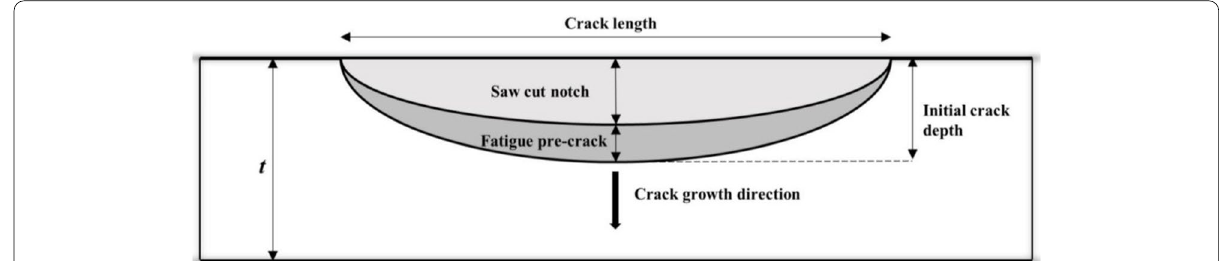
Fig. 3 Schematic diagram of notch and pre-crack on pipe surface